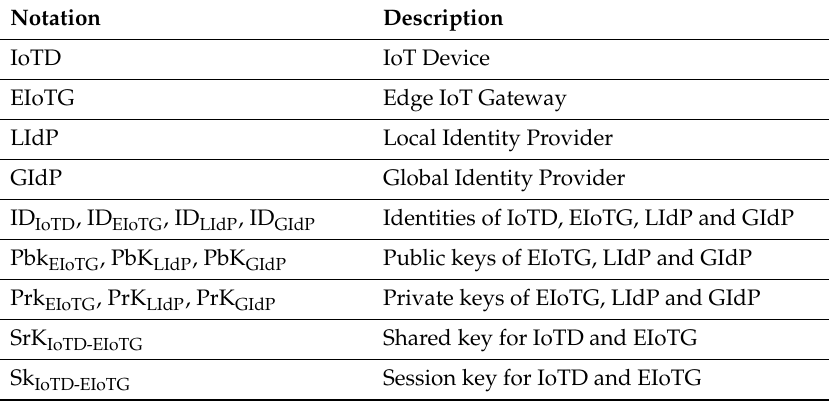
Table 1. Di ff erent terms notation and descriptions